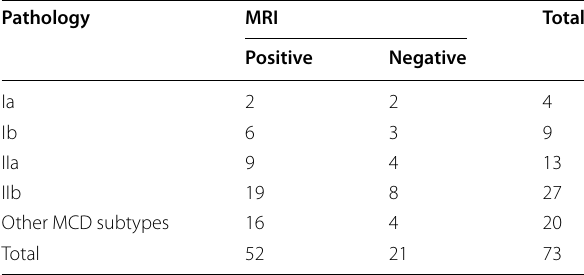
Table 5 Pathology and MRI Pathology